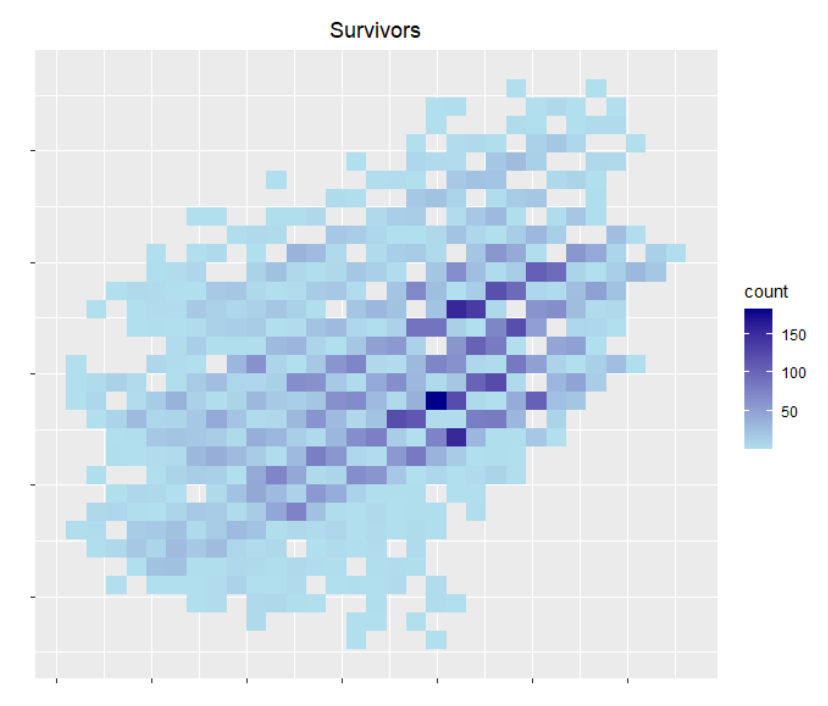
Figure 1. Density plot of observations projected onto the two-dimensional plane. Top in red are deaths, and bottom in blue are survivors. The axis values have been excluded, as they come from projecting categorical features coded as numeric onto the two-dimensional plane and do not have discernible biological meaning.